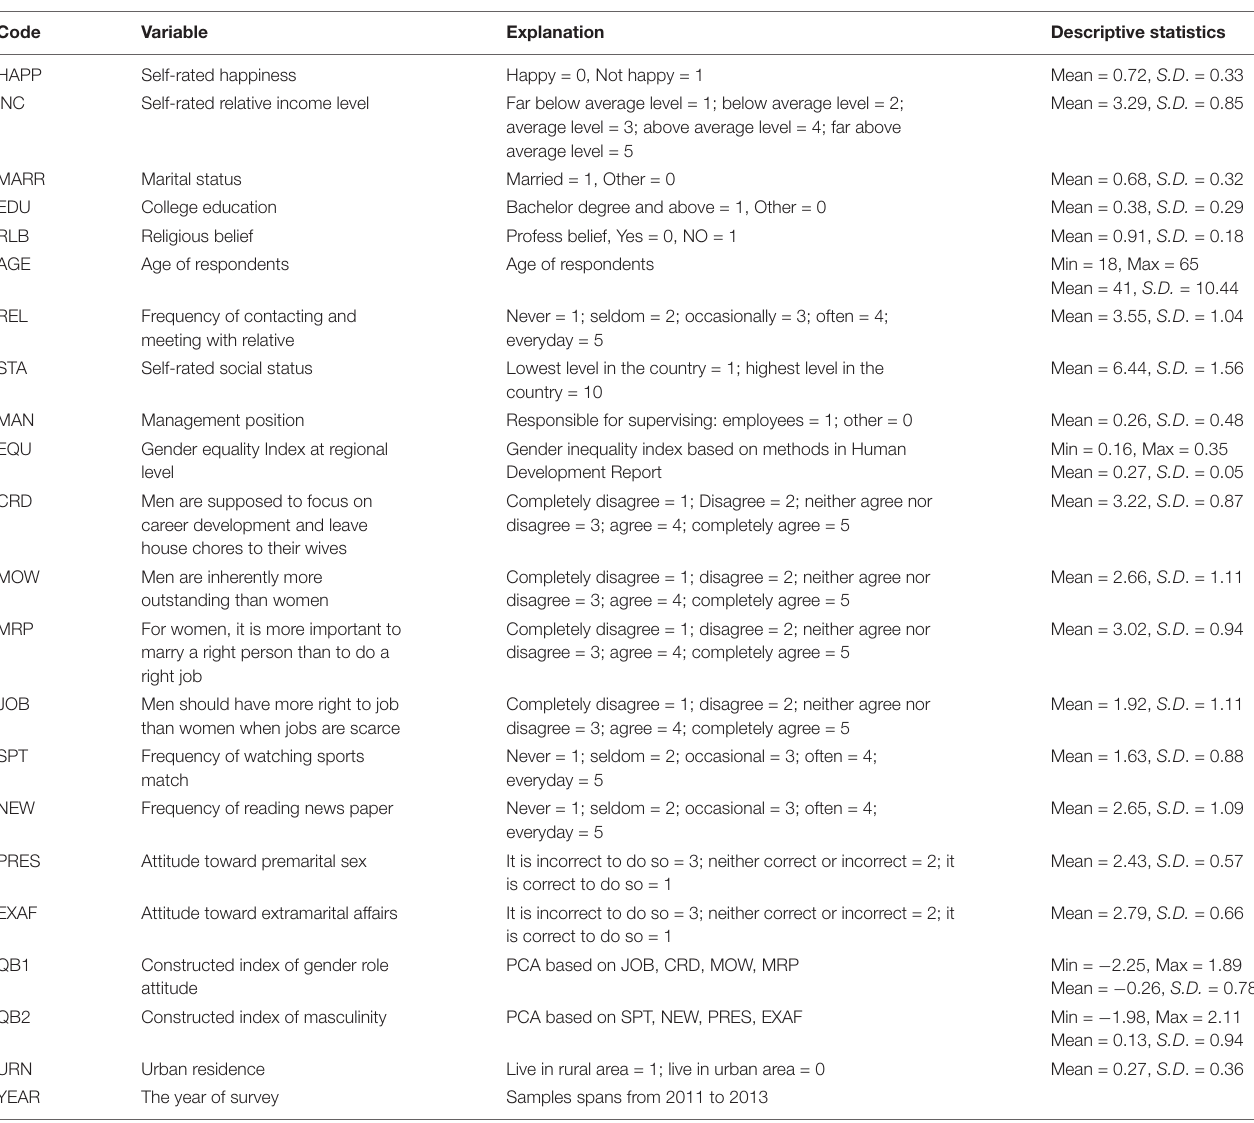
TABLE 3 | Explanations on